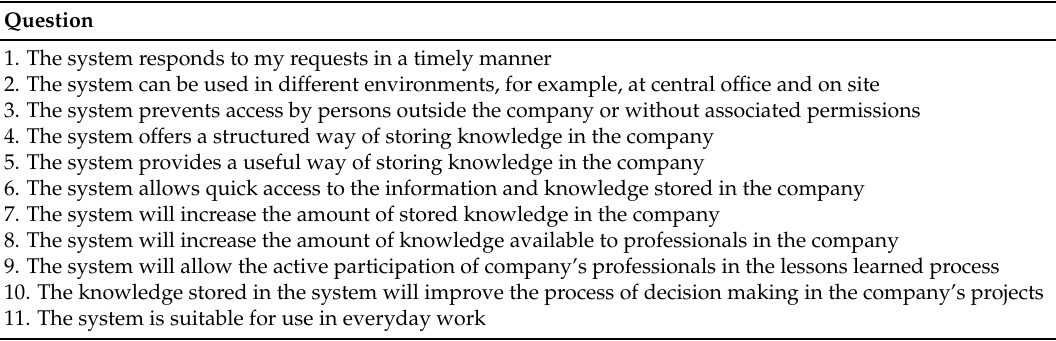
Table 3. Affirmations to answer using a Likert scale regarding the propose